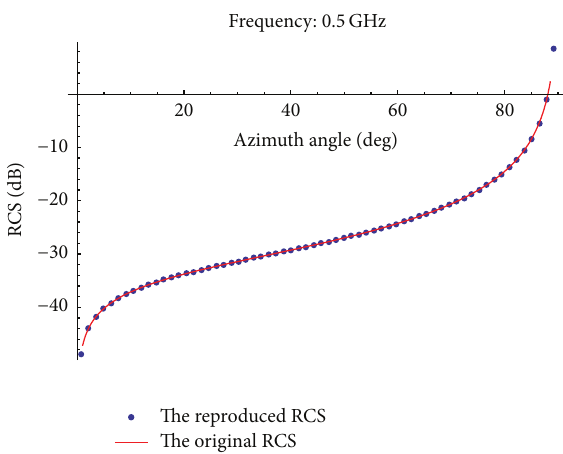
Figure 3: Backscattered RCS for an elliptical cylinder of 𝑘 = 5 and 𝜑 = 45 ∘ .